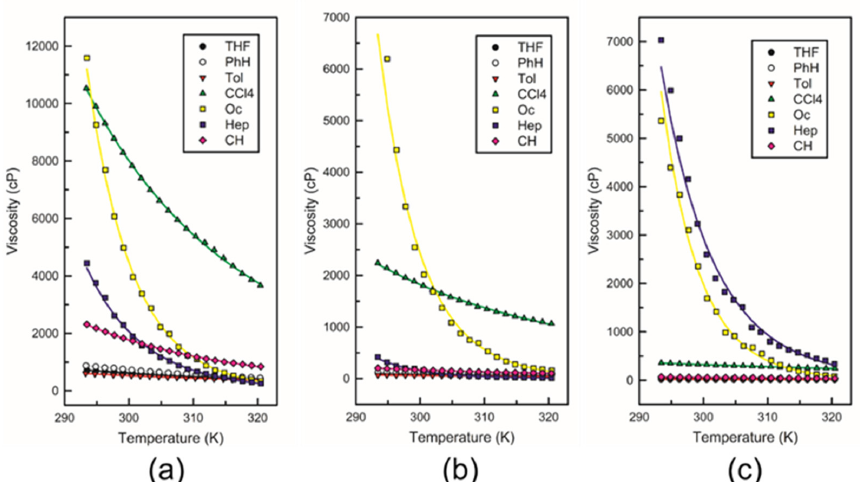
Figure 6. Viscosity versus temperature plots of adhesive solutions prepared with different adhesive weight percent: ( a ) 50%; ( b ) 33%; ( c ) 25%. The data points are viscosity data obtained from experiment, and solid lines are fittings of the data to Arrhenius Model. Table 1. Fitting parameters of the adhesive solution viscosity data to Arrhenius Model. Adhesive wt.%